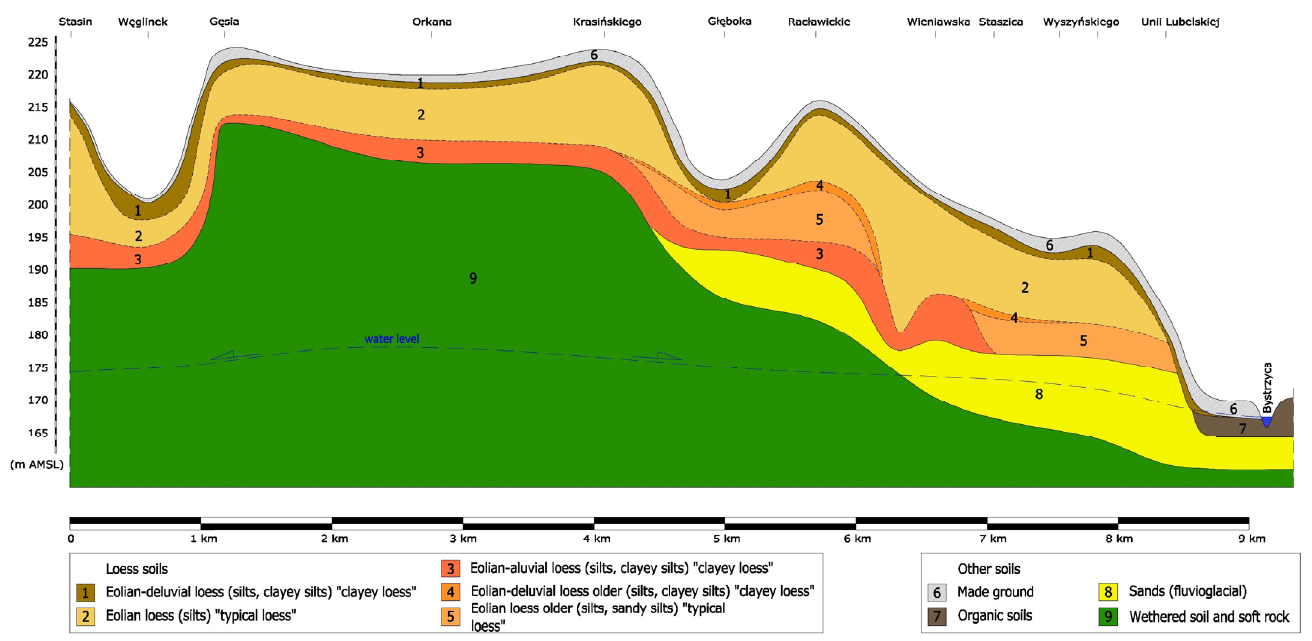
Figure 3. The geological structure of Lublin—a representative